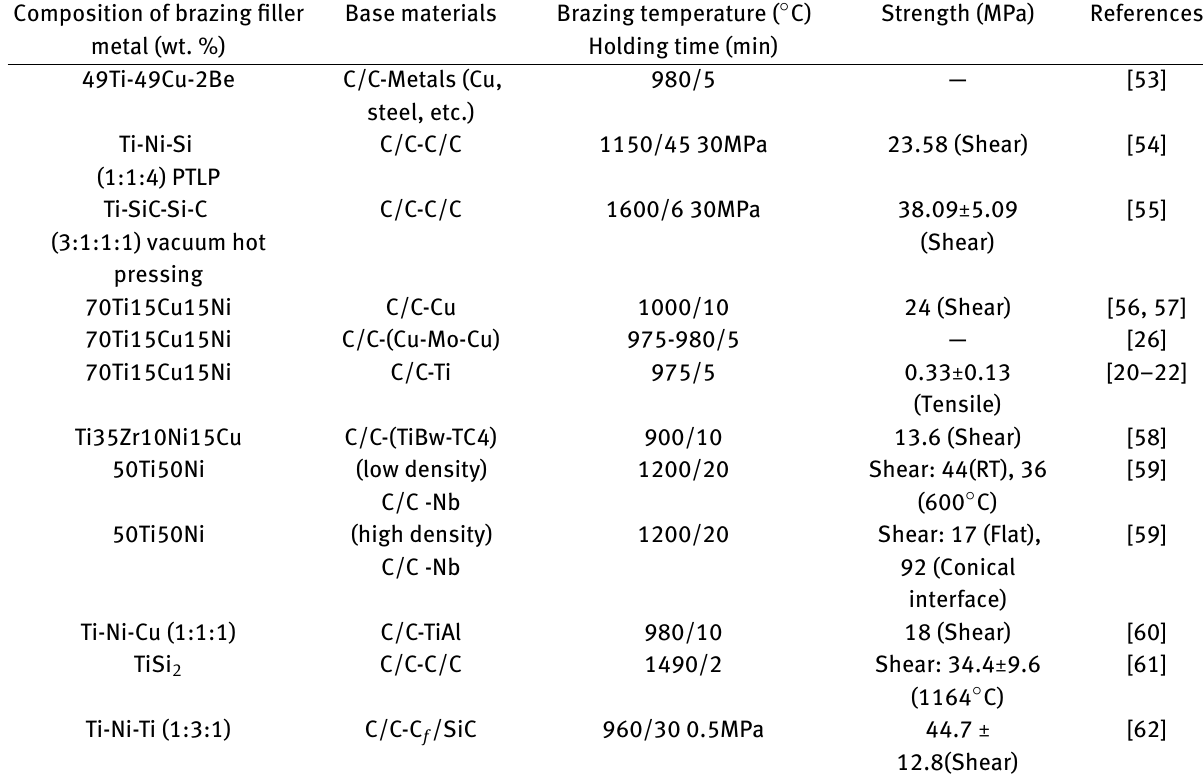
Table 4: Ti-based brazing filler metals used in joining of C/C composites Composition of brazing